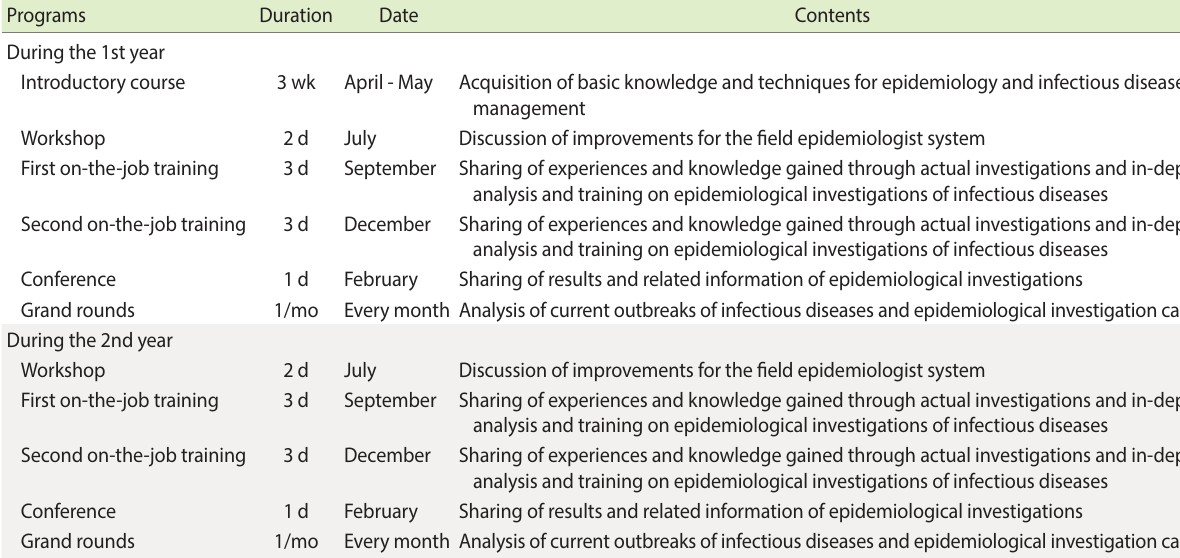
Table 2. Field epidemiology training program courses in Korea